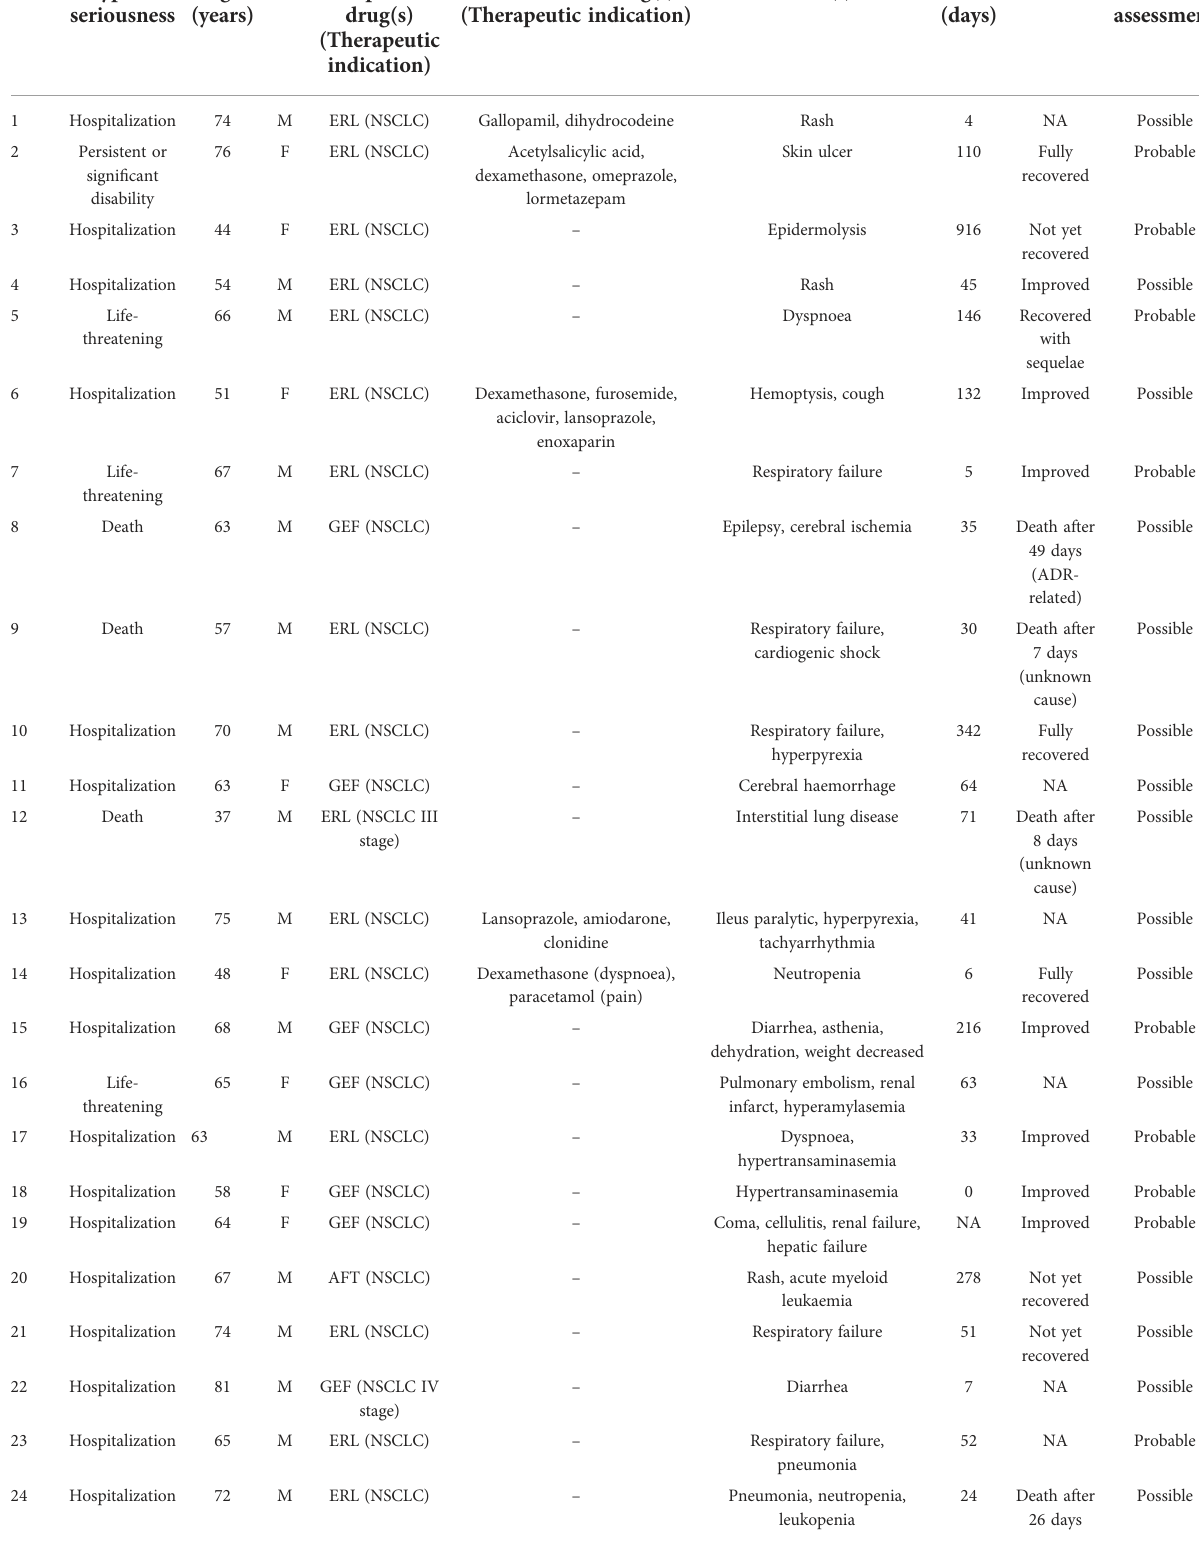
TABLE 5 Detailed description of Sicilian SADR reports related to TKIs for